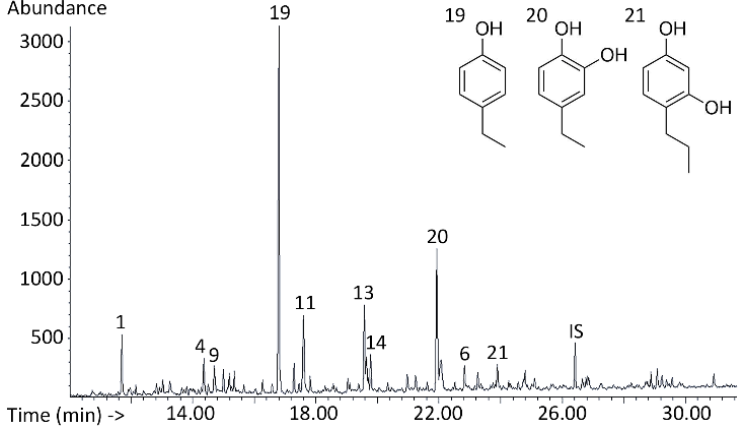
Figure 3. Chromatogram of the oil from experiment G3-deac-360. Internal standard (IS) is hexadecane.